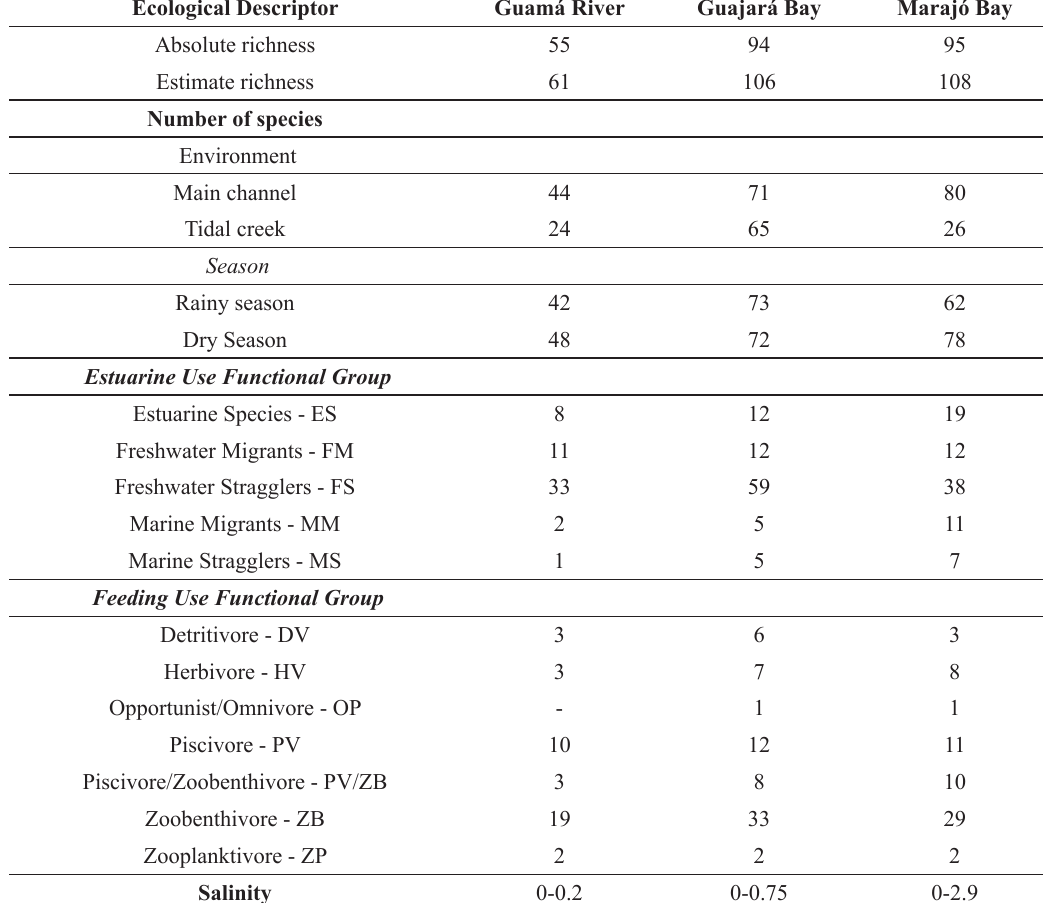
Ecological descriptor and number of species by environment, season and guilds in the Guamá River, Guajará Bay and Marajó